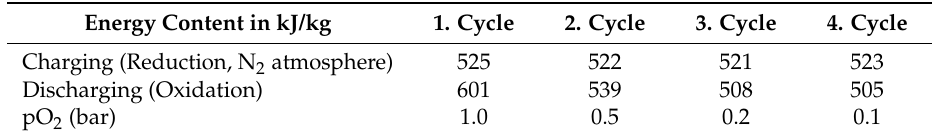
Figure 6. Differential scanning calorimetry (DSC) peaks of oxidation and reduction of Cu 2 O/CuO at 930 °C with variation in the partial pressures (1.0, 0.5, 0.2, and 0.1 bar). Table 1. Specific energy content in kJ/kg of the reduction (charge) and oxidation (discharging) steps of the Cu 2 O/CuO system for each cycle at 930 °C.